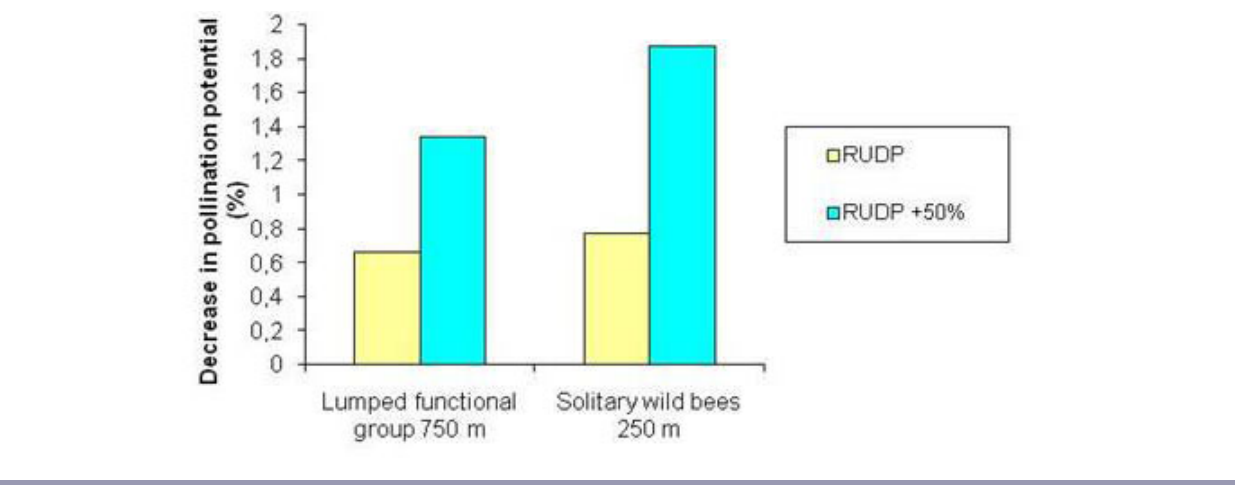
Fig. 4 . Change in pollination potential under both the moderate and the amplified Regional Urban Development Plan (RUDP) in combination with the non-pollinated crop scenario for both the lumped functional pollinator group and when observing solitary bees and generalists